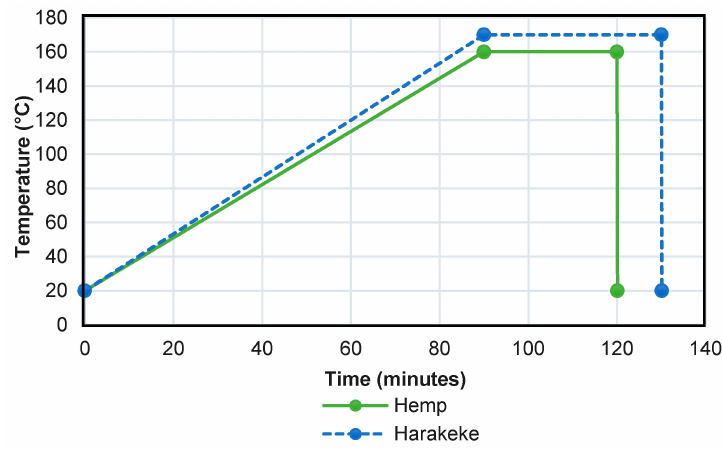
Figure 3. Digester schedules for hemp and harakeke